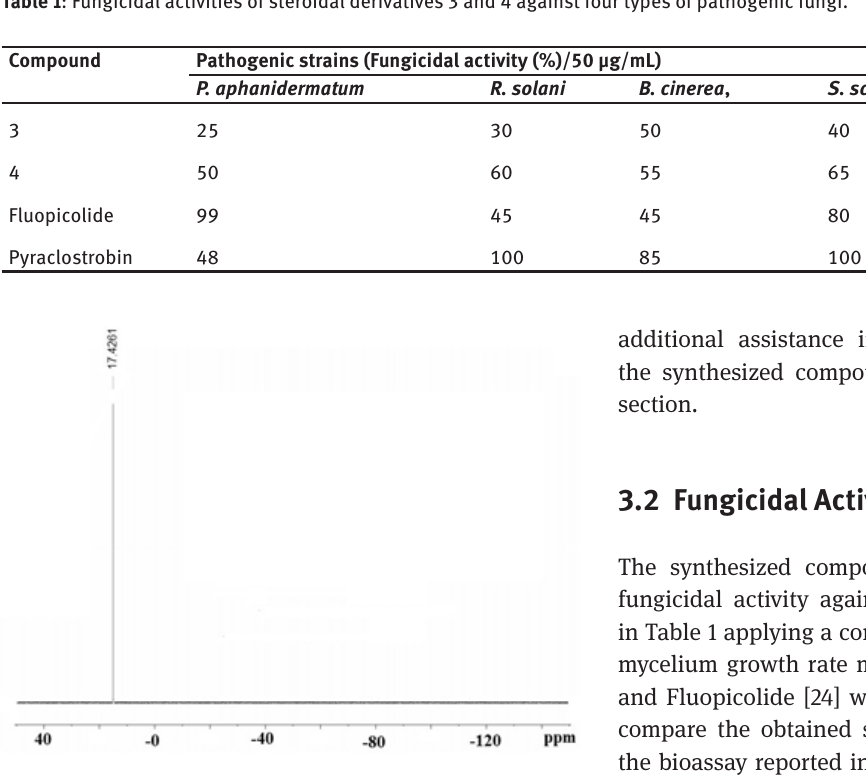
Figure 3: 31 P NMR spectrum of 3β-oxo-[diazaphosphalidine-2’-one] stigmast-5-ene.